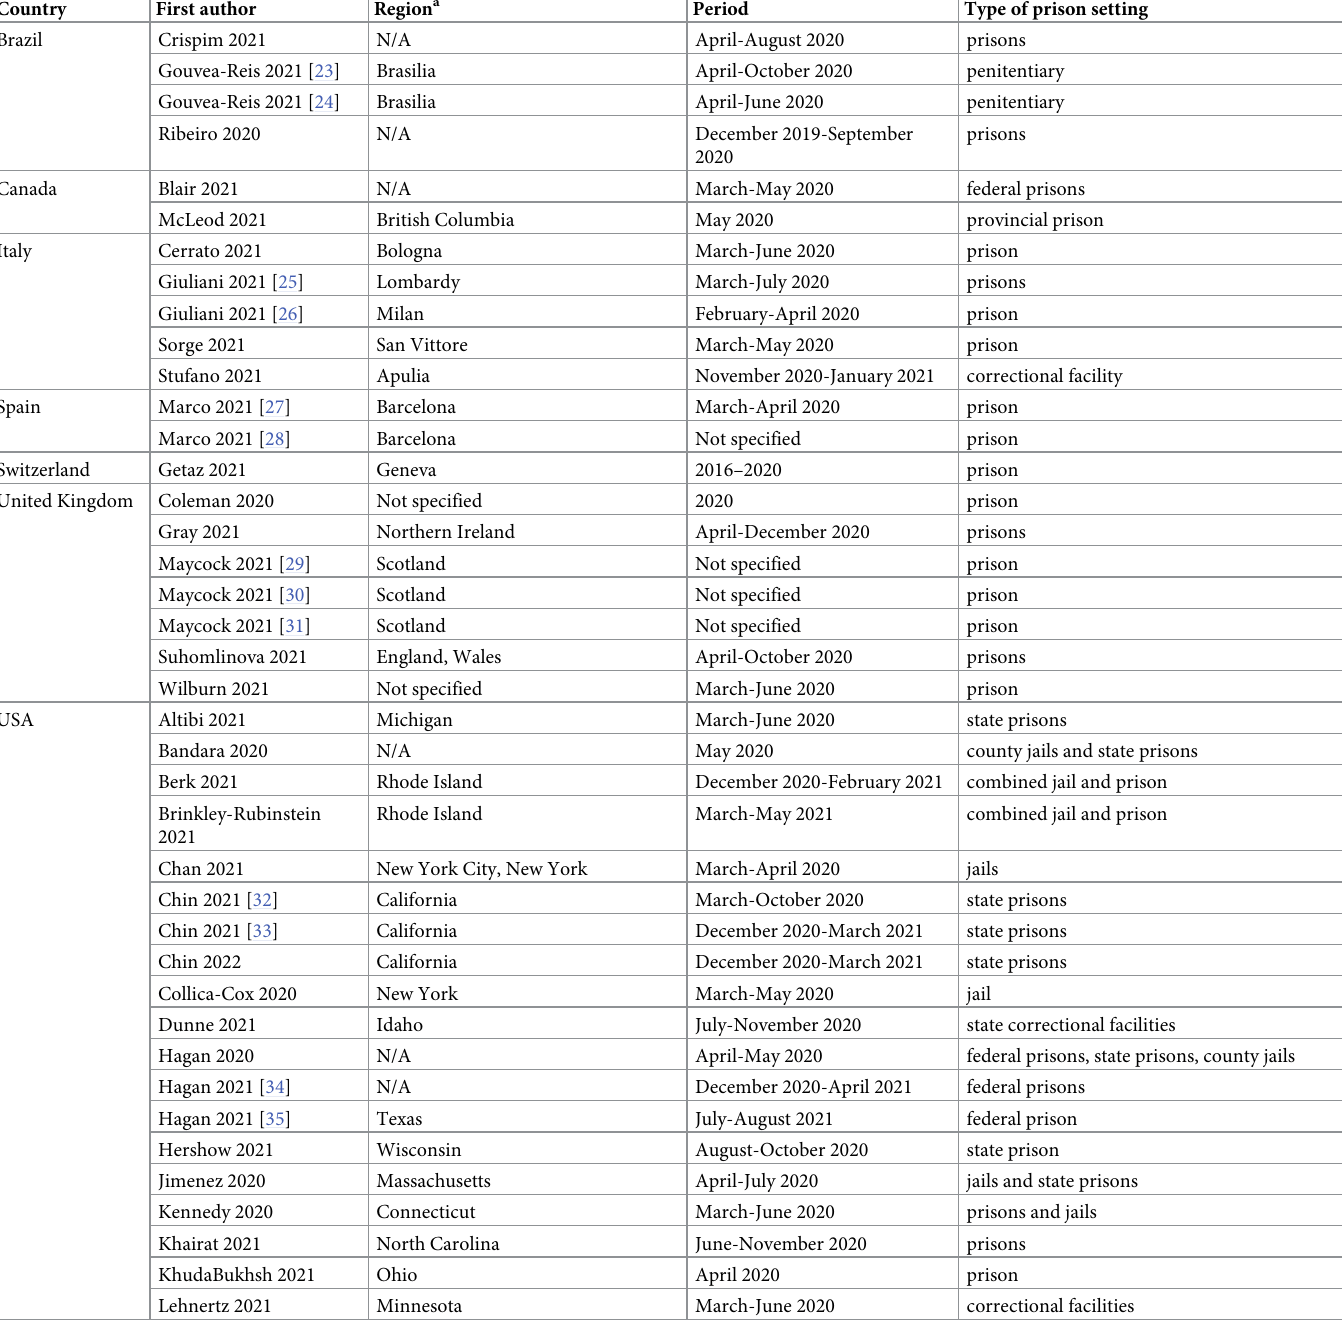
Table 1. Characteristics of studies included in a systematic review on the health impacts of the COVID-19 pandemic on people who experience imprisonment, N = 62.